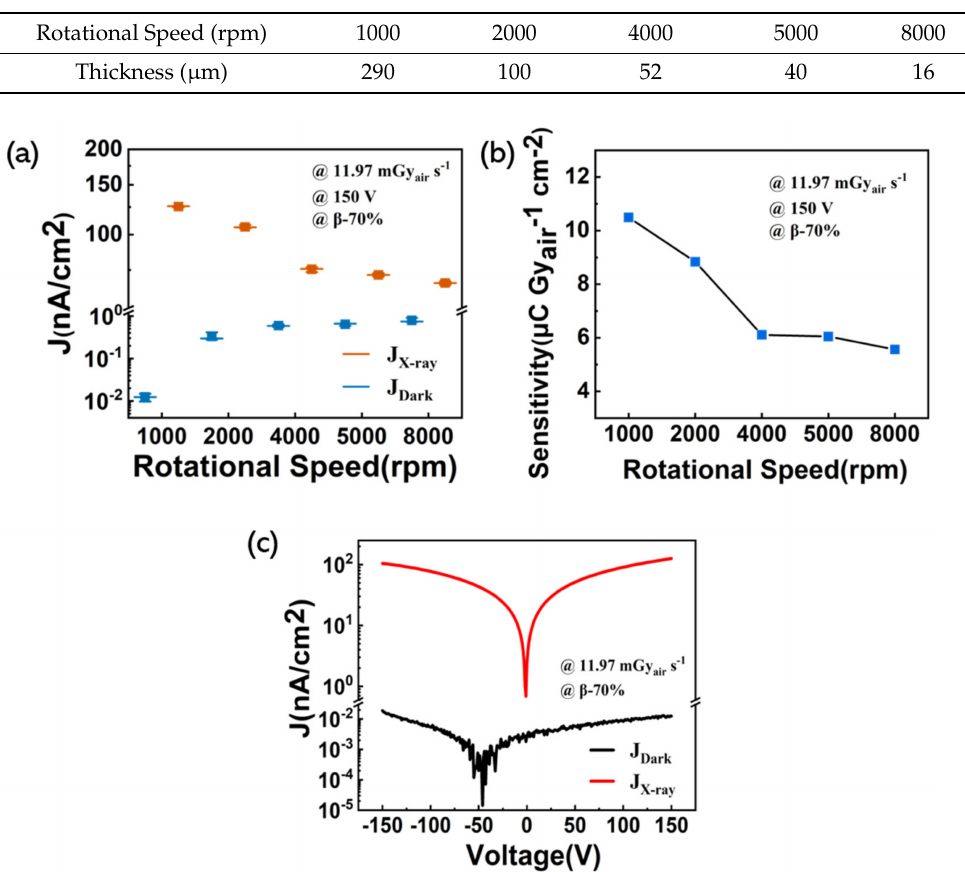
Figure 5. ( a ) The X-ray and dark current density of device β -70% with different thicknesses; ( b ) the sensitivity of device β -70% with different thicknesses; ( c ) I − V characteristics of the β -70% detector (1000 rpm) in the dark and under X-ray irradiation on a logarithmic